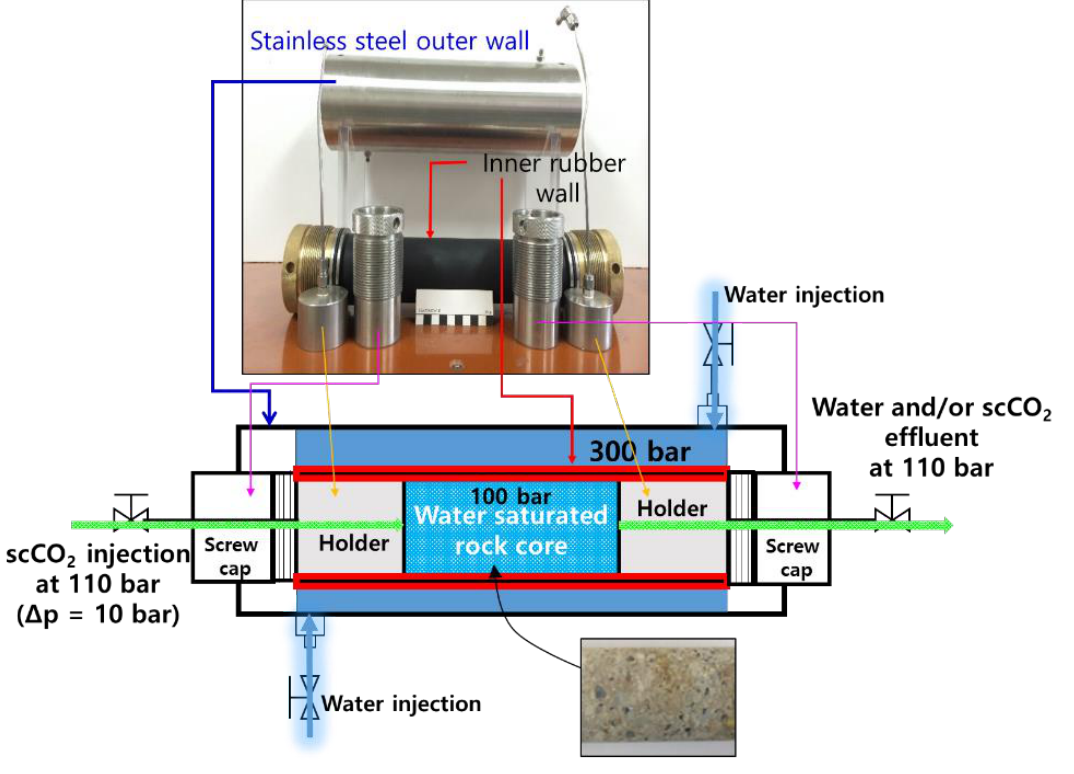
Figure 2. Photograph of the high-pressure cell used for the experiment to measure the supercritical CO 2 (scCO 2 ) storage ratio.